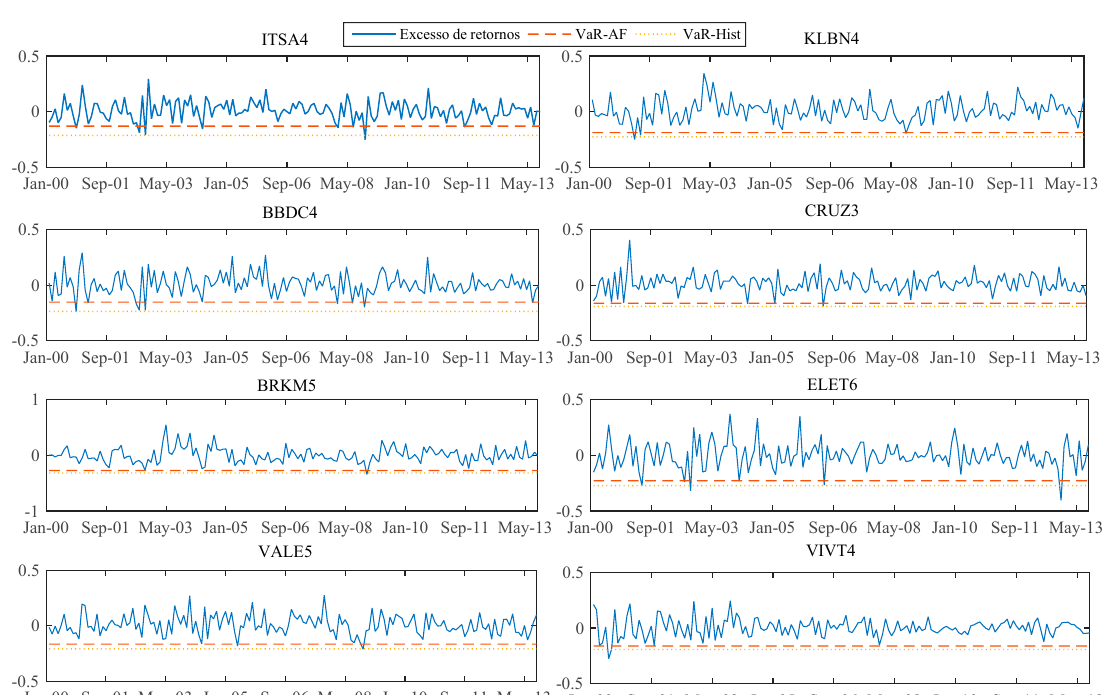
Figure A5. A&F models VaR versus versus historical VaR.